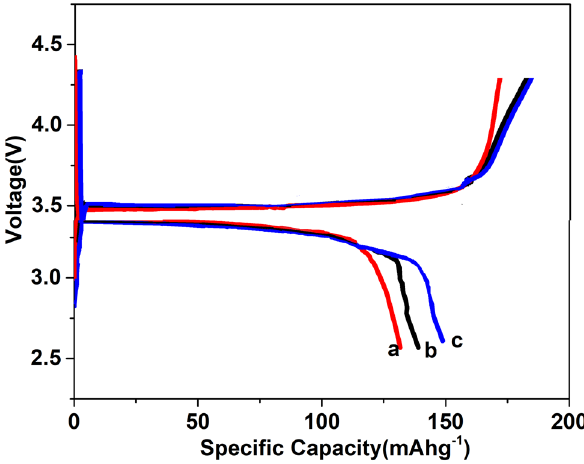
Fig. 9 1st cycle of charge and discharge curves of Swagelok cells with a PVdF, b PVdF–PMMA (80:20), and c PVdF–PMMA (50:50) nanofibrous polymer electrolyte membranes